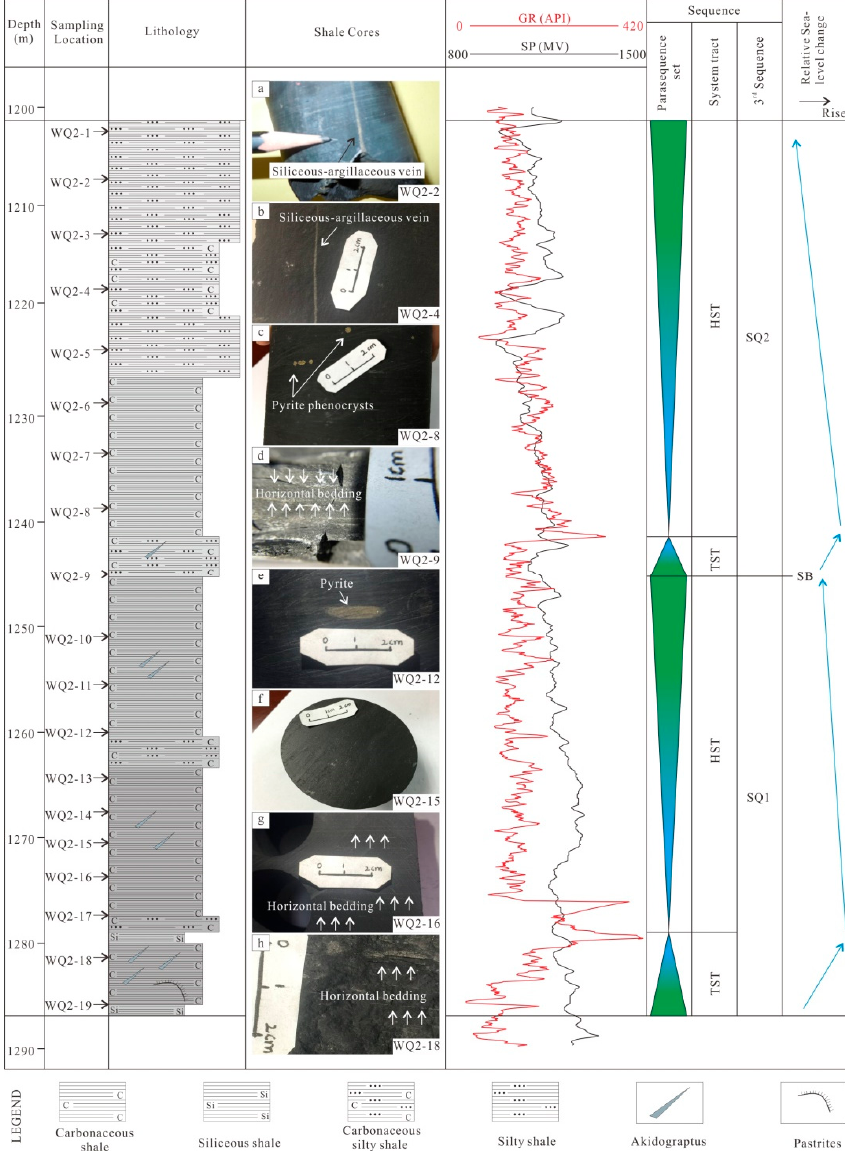
Figure 3. Vertical variations in the lithofacies, sedimentary sequence, and relative sea level of the Lower Silurian Longmaxi formation (LSL) of Well-WQ2. TST = transgressive system tract. HST = a high-stand system tract. SB = sequence boundary. ( a , b ) Tawny siliceous-argillaceous veins with a width of ~1 mm; ( c ) Pyrite phenocrysts with good roundness (diameter of ~1 mm); ( d , g , h ) Horizontal bedding structure shown by the cross-sections of cores; ( e ) Pyrite spot with an elliptical shape; ( f ) Typical pure carbonaceous shale.